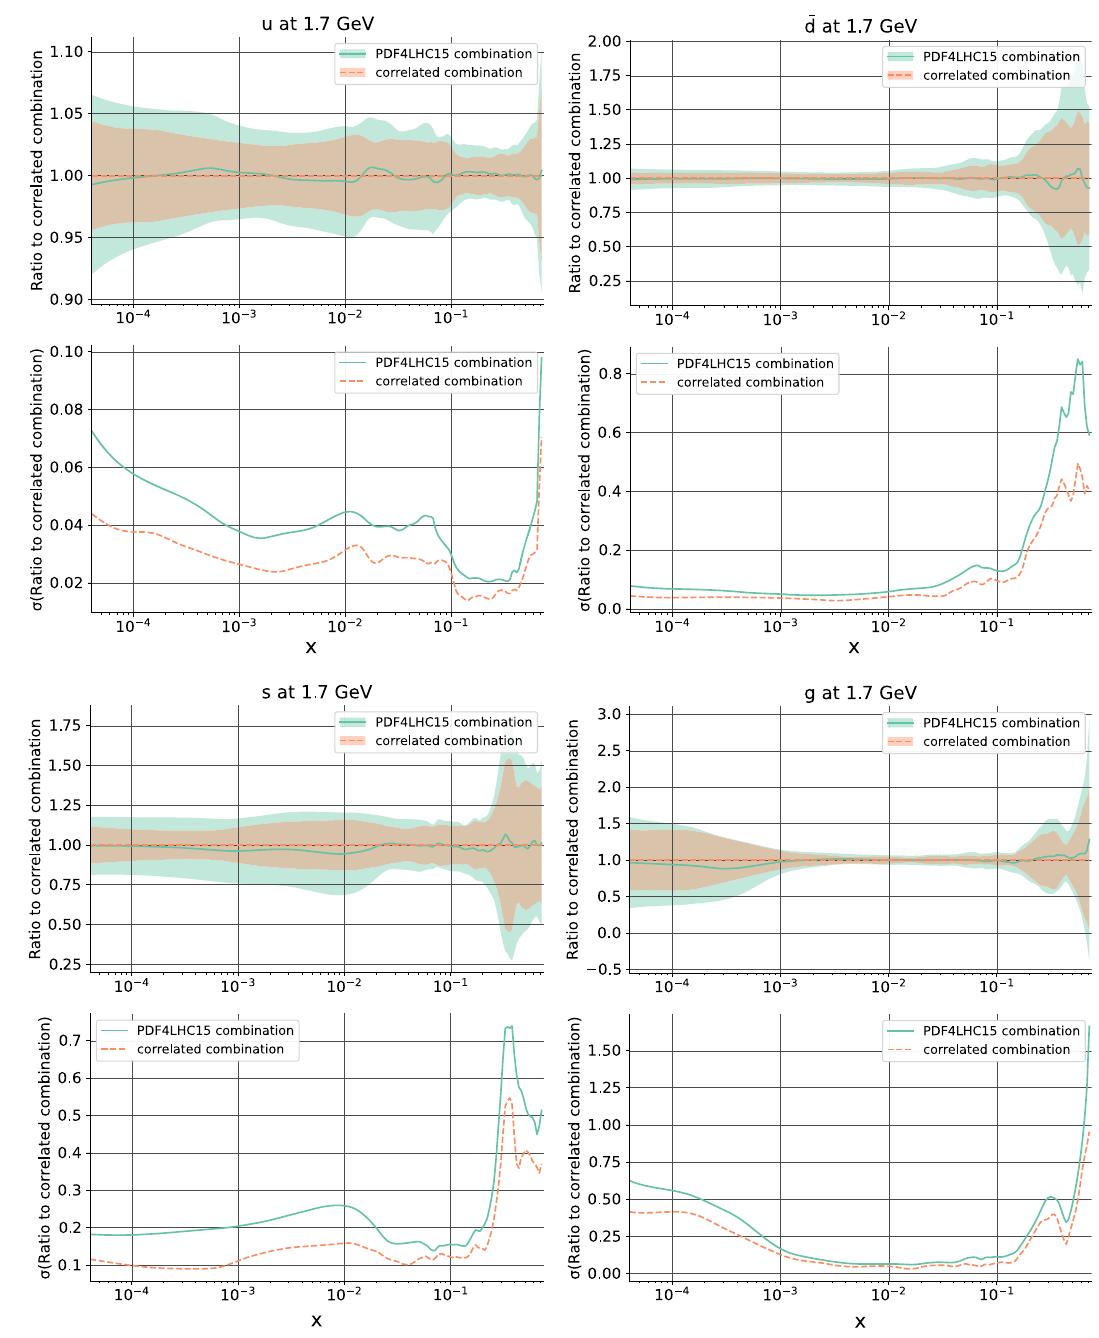
Fig. 8 Comparison of the uncertainty on the correlated PDF com- bination and the PDF4LHC15 combination for 10 sets of 43 PDF NNPDF4.0 replicas. The correlated combination is obtained as the cor-